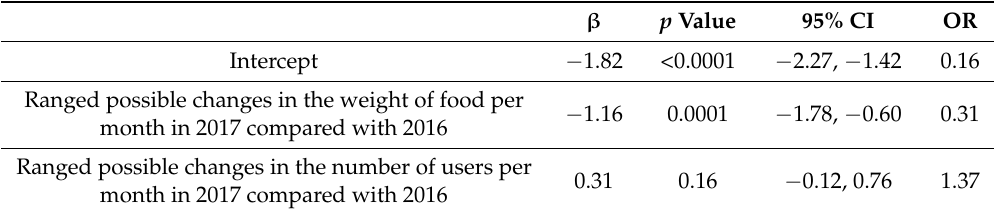
Table 3. Association between the log of having a lack of food and the ranked possible changes in the number of users and the distributed food. Results of logistic regression analyses. β p Value 95% CI OR Intercept − 1.82